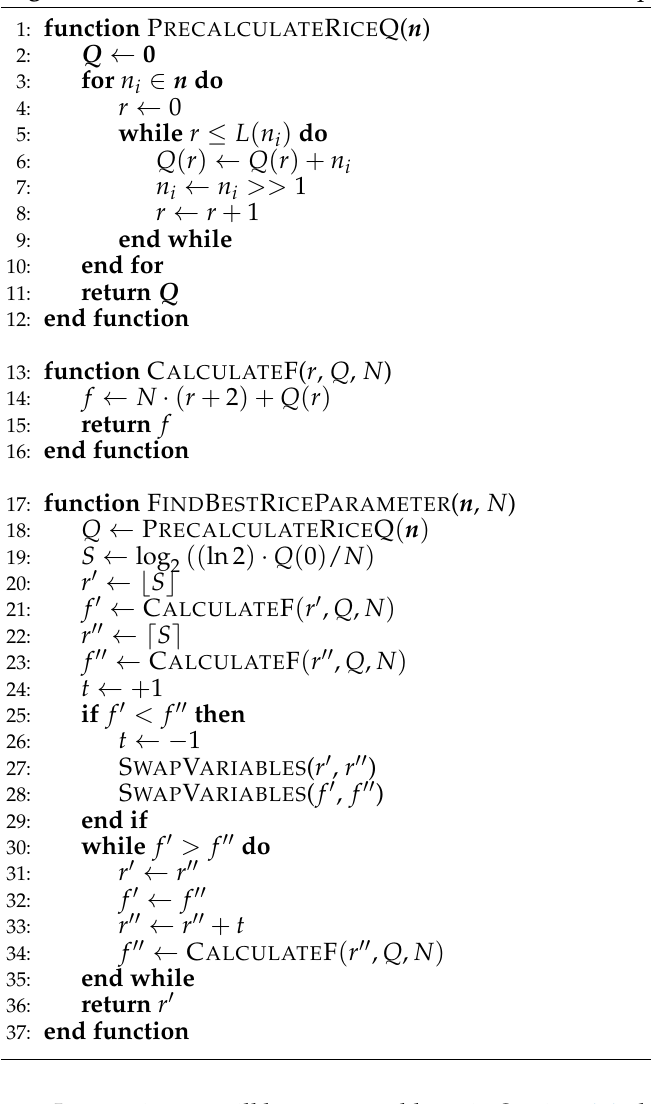
Algorithm 1 Online calculation of the Rice-code with complexity O ( L max · N )